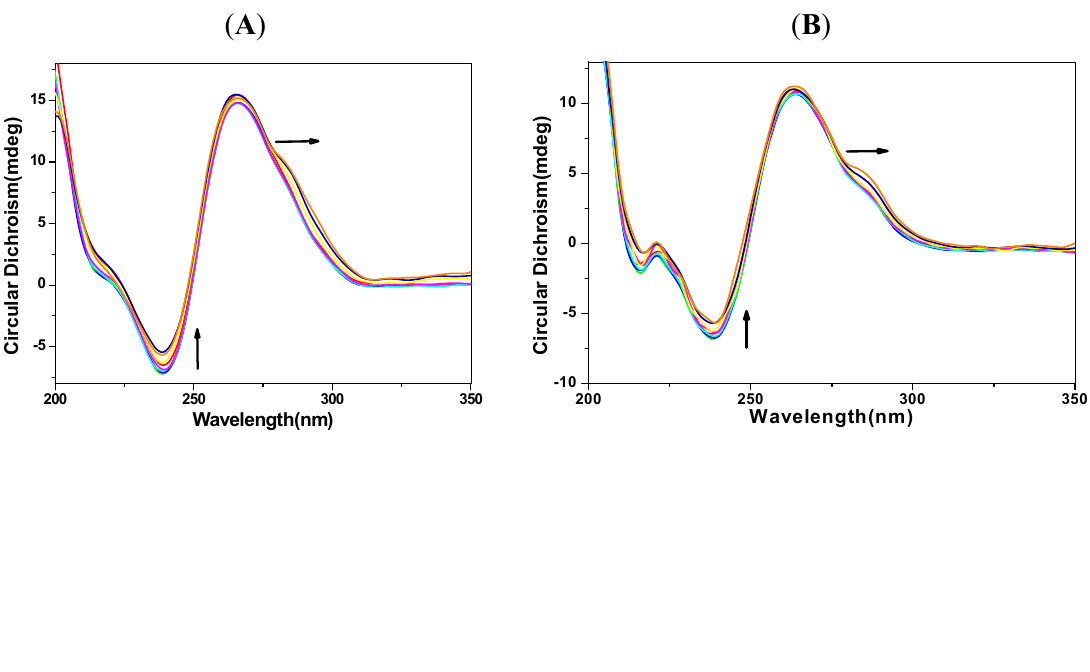
Figure 5. CD and ICD spectra of DNA solutions (5  mol/L) with the addition of 1-PBO (0–20  mol/L). ( A ) CD spectra of p53 DNA; ( B ) CD spectra of C-myc DNA; ( C ) ICD spectra of p53 DNA and ( D ) ICD spectra of C-myc